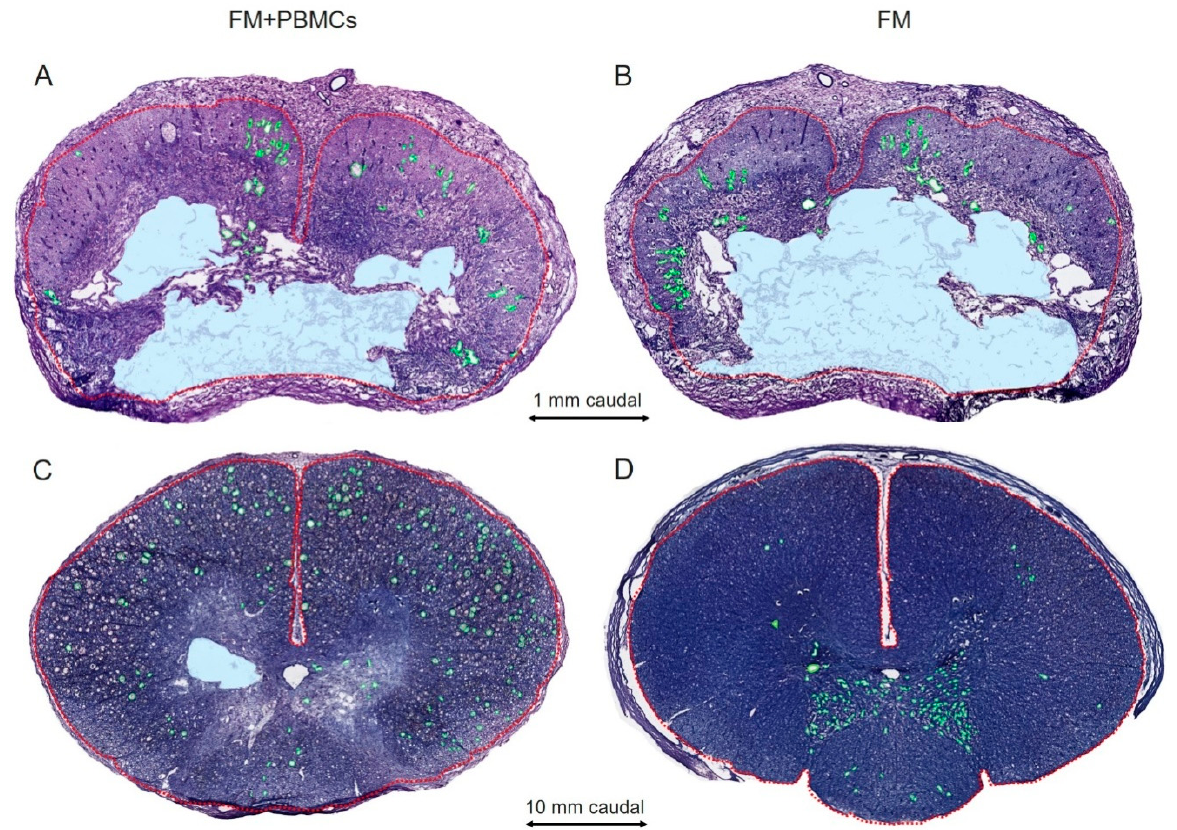
Figure 3. Examples of spinal cord morphometry in experimental pigs. Cross-sections of the injured spinal cord at a distance of 1 ( A , B ) and 10 ( C , D ) mm caudally from the injury epicenter at 22 weeks after SCIs in experimental pigs. Azur–eosin staining. Dashed red lines indicate the outer border of the spinal cord; green lines and blue areas are examples of small and large post-traumatic cavity determination. Note that areas of the spared tissue in large post-traumatic cavities have also been analyzed.